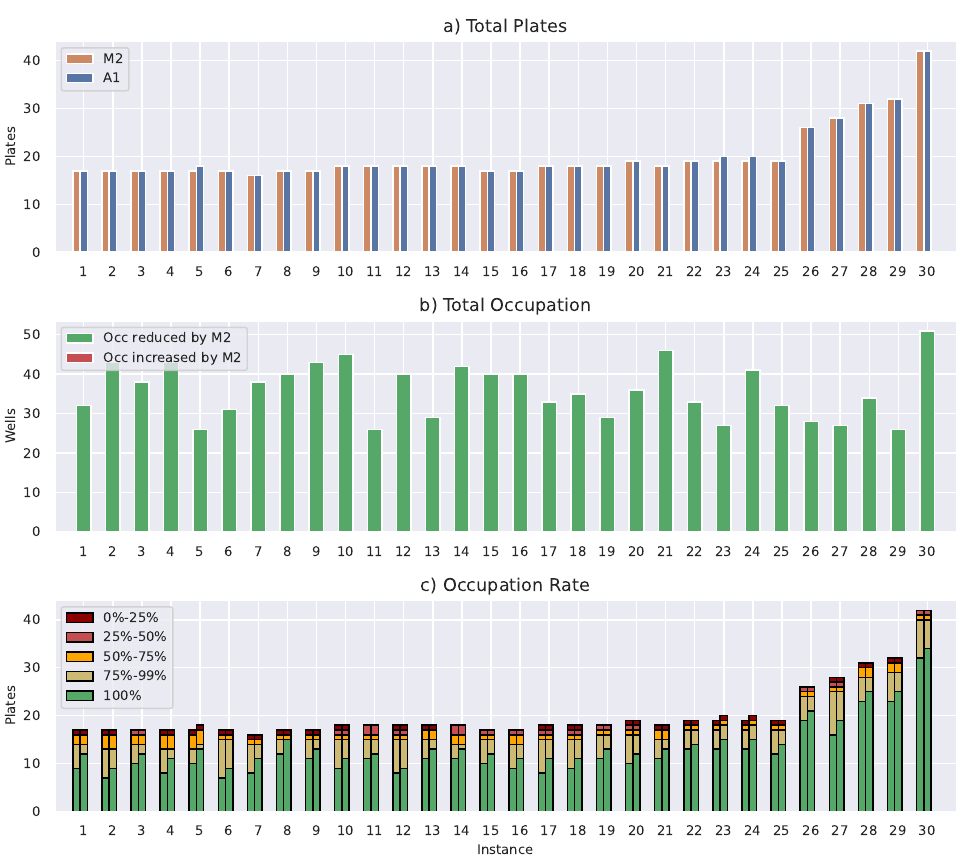
Figure 10. Comparison of M2 and A1 on all available